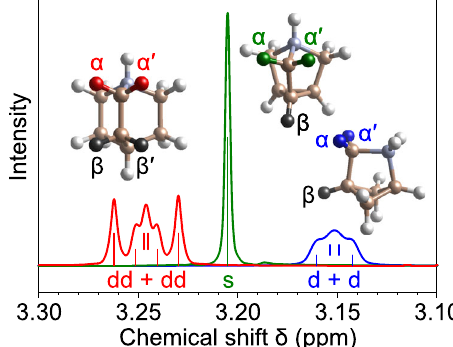
Fig. 1 Comparison between the NMR splitting patterns of the α methylene protons of Abh + Cl − (blue), Ath + I − (green), and Q + I − (red) in DMSO- d 6 . The α protons of Ath + exhibits a singlet peak, apparently not coupled to its β proton. Vertical lines indicate peak positions obtained from curve fi tting. (Supplementary Figs. 2 – 4). Figure 1 plots the solution-phase NMR spectra of three polycyclic